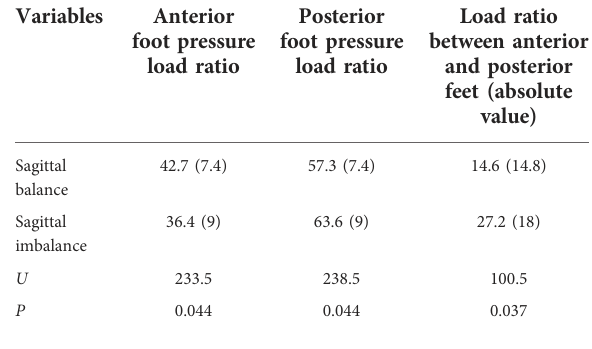
TABLE 4 Correlation analysis between TPA and parameters in the sagittal plane.